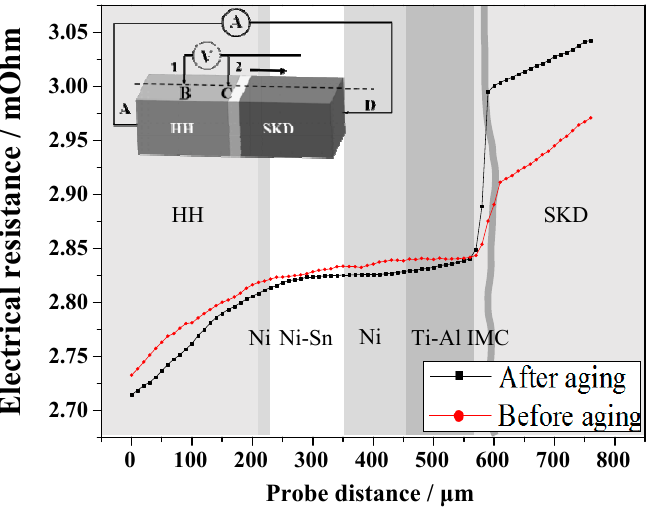
Figure 2. Electrical resistance across the HH/SKD joint before and after isothermal aging.